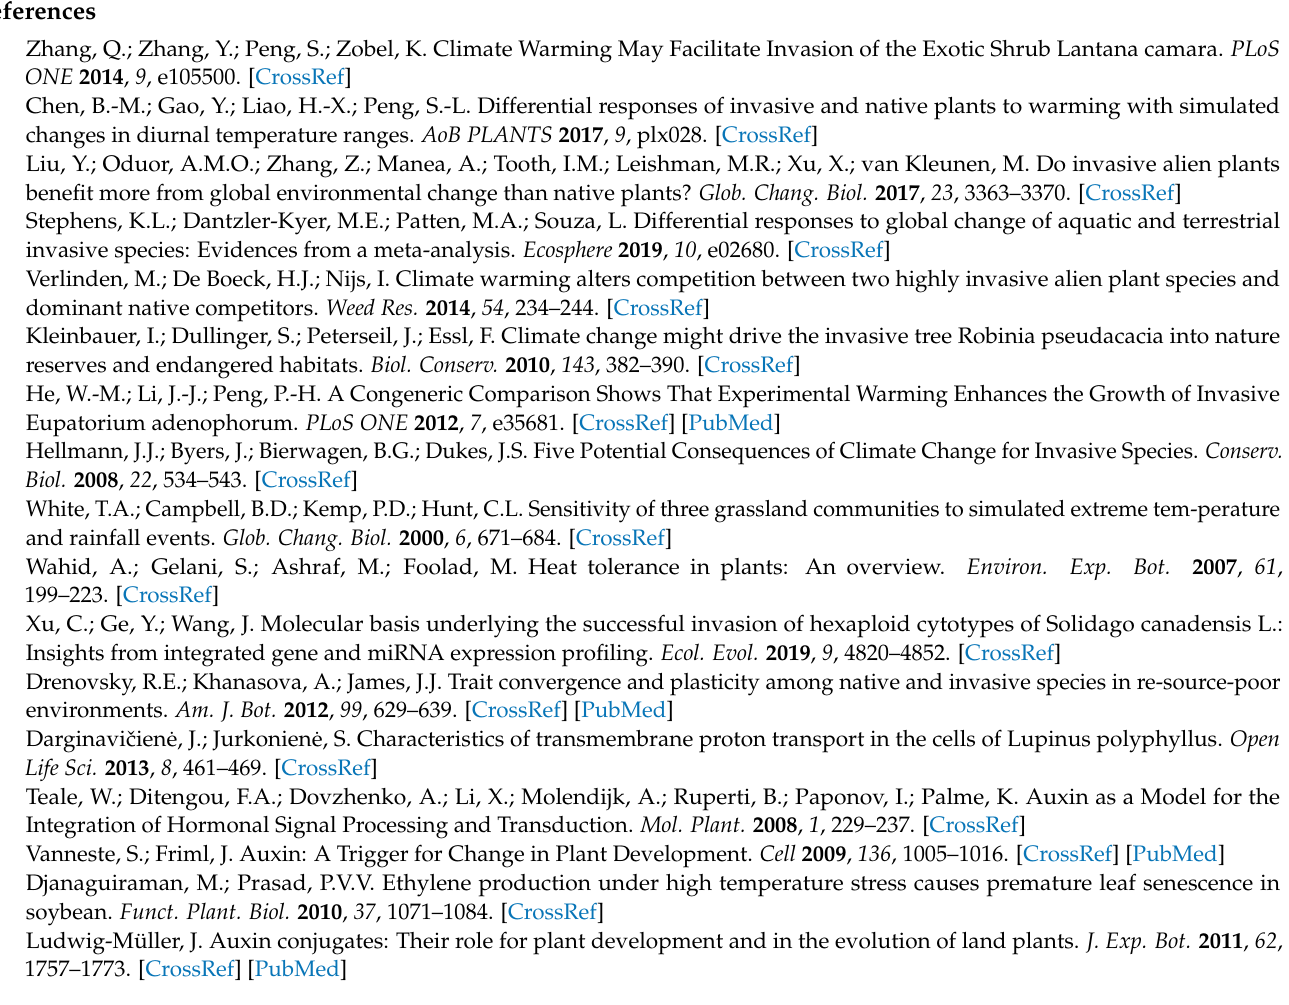
Figure A1. Development of L. polyphyllus seedlings under 25 °C temperature: 0 h ( A ), 24 h ( B ), 48 h ( C ) and 72 h ( D ). Scale bar, 1 cm.